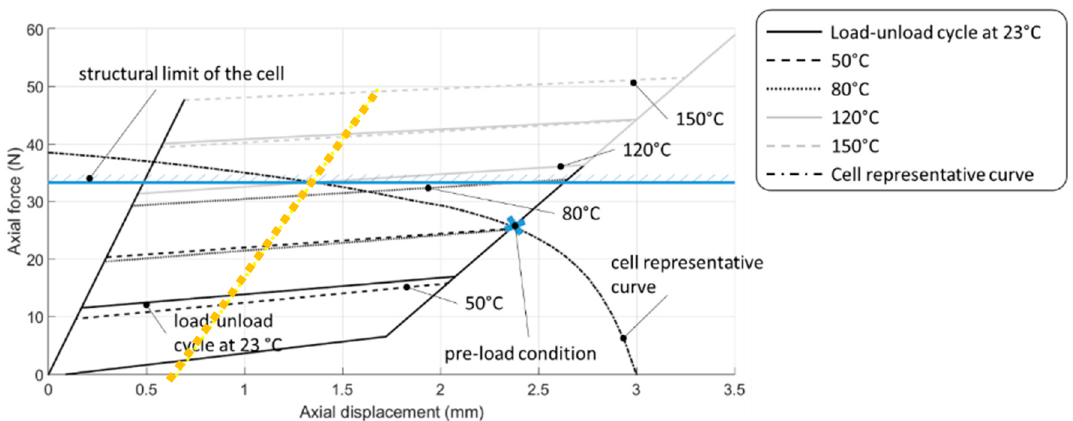
Figure 10. Operational points of the expanding cell.